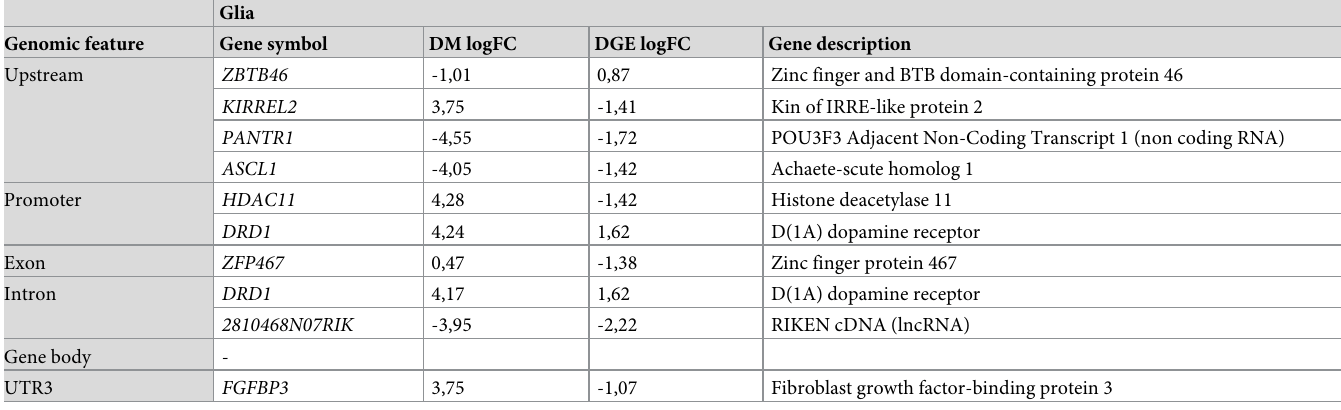
Table 6. Association between DMR and DGE in glia at 24 hours post